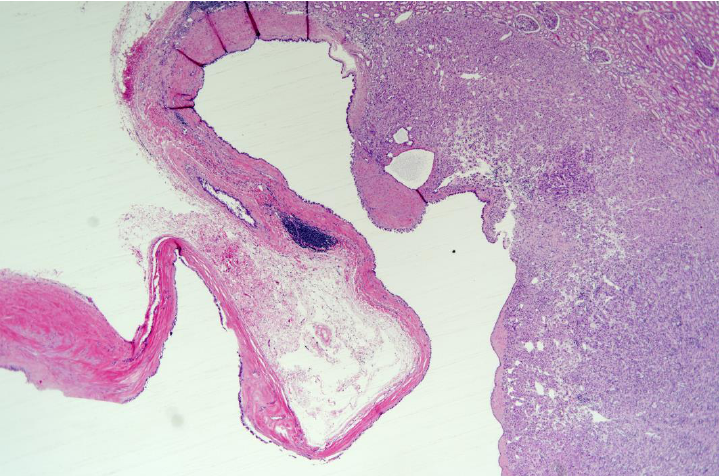
Figure 2. The tumor comprised a mixture of variably sized cysts and tubules (left side). The right side showed poorly differentiated tumors. (H&E stain, ×20).